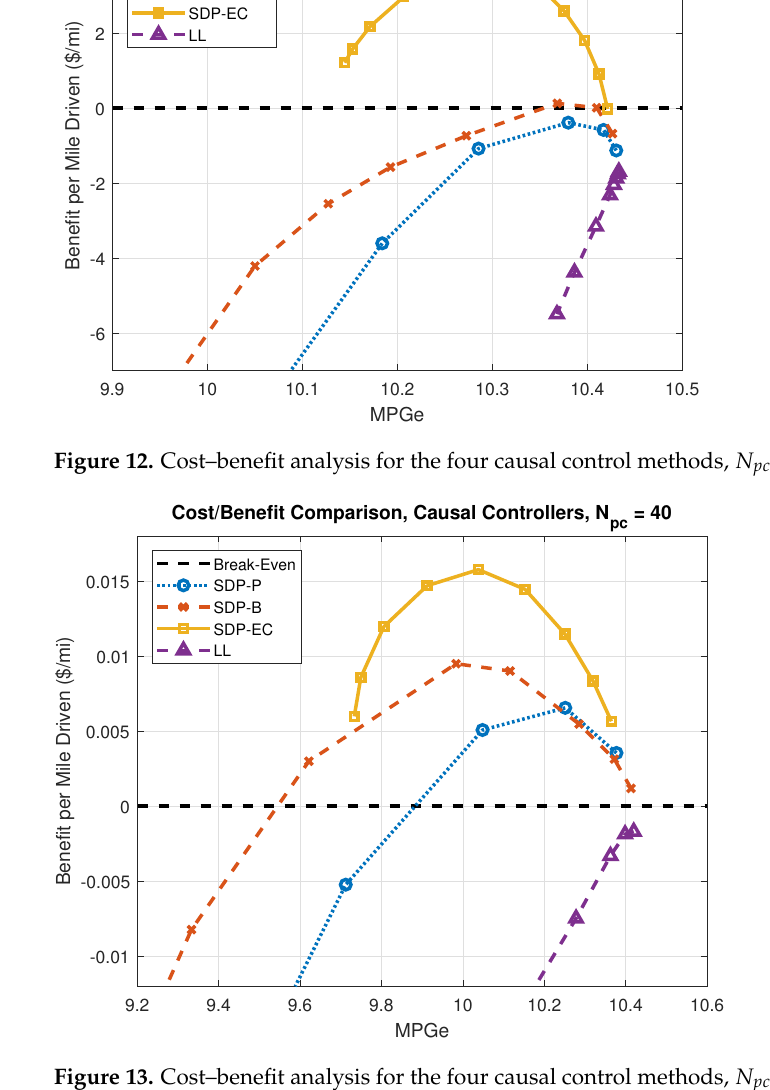
Figure 13. Cost–benefit analysis for the four causal control methods, N pc = 40. Another takeaway from Figure 12 is that the peak economic benefit occurs at a higher MPGe (lower ultracapacitor utilization) than the peak lifespan increase. This makes intuitive sense: lifespan improvements level off near the peak while energy consumption continues to grow. Therefore, near the lifespan peak, the marginal improvement battery- cost-per-mile is less than the marginal decrease in fuel economy. For the N pc = 100 SDP-EC method, there is not much difference between the peak lifespan increase (occurring at 9.71 MPGe) and the peak benefit (occurring at 9.80 MPGe); however, for a smaller HESS or for weaker strategies, the difference can be substantial: in the N pc = 100 case, the SDP-B peak lifespan increase is at 9.51 MPGe, which is effectively break-even in terms of value, while the peak benefit occurs at 9.75 MPGe. SDP-P has its peak benefit at 10.06 MPGe and peak lifespan at 9.32 MPGe; looking at the the SDP-EC method in the N pc = 10 case, the benefit at the peak lifespan increase is approximately half of the maximum possible benefit. Clearly, the economic factors should be considered when deciding on the controller